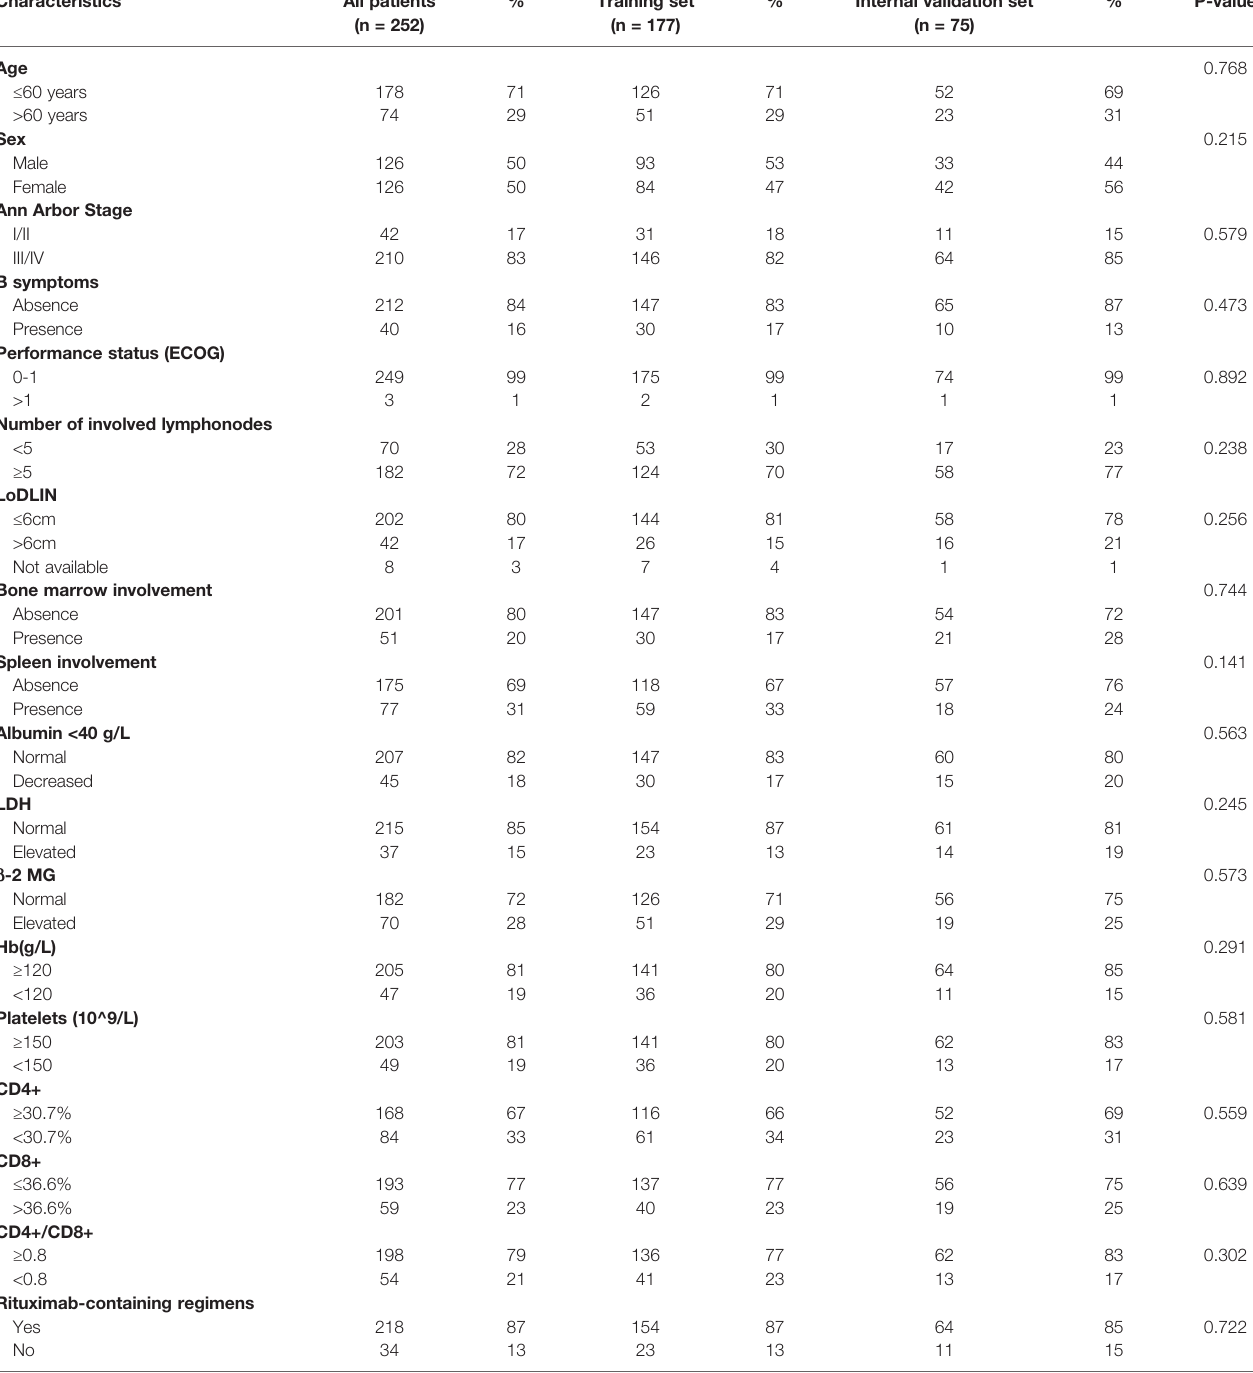
TABLE 1 | Baseline patient characteristics.